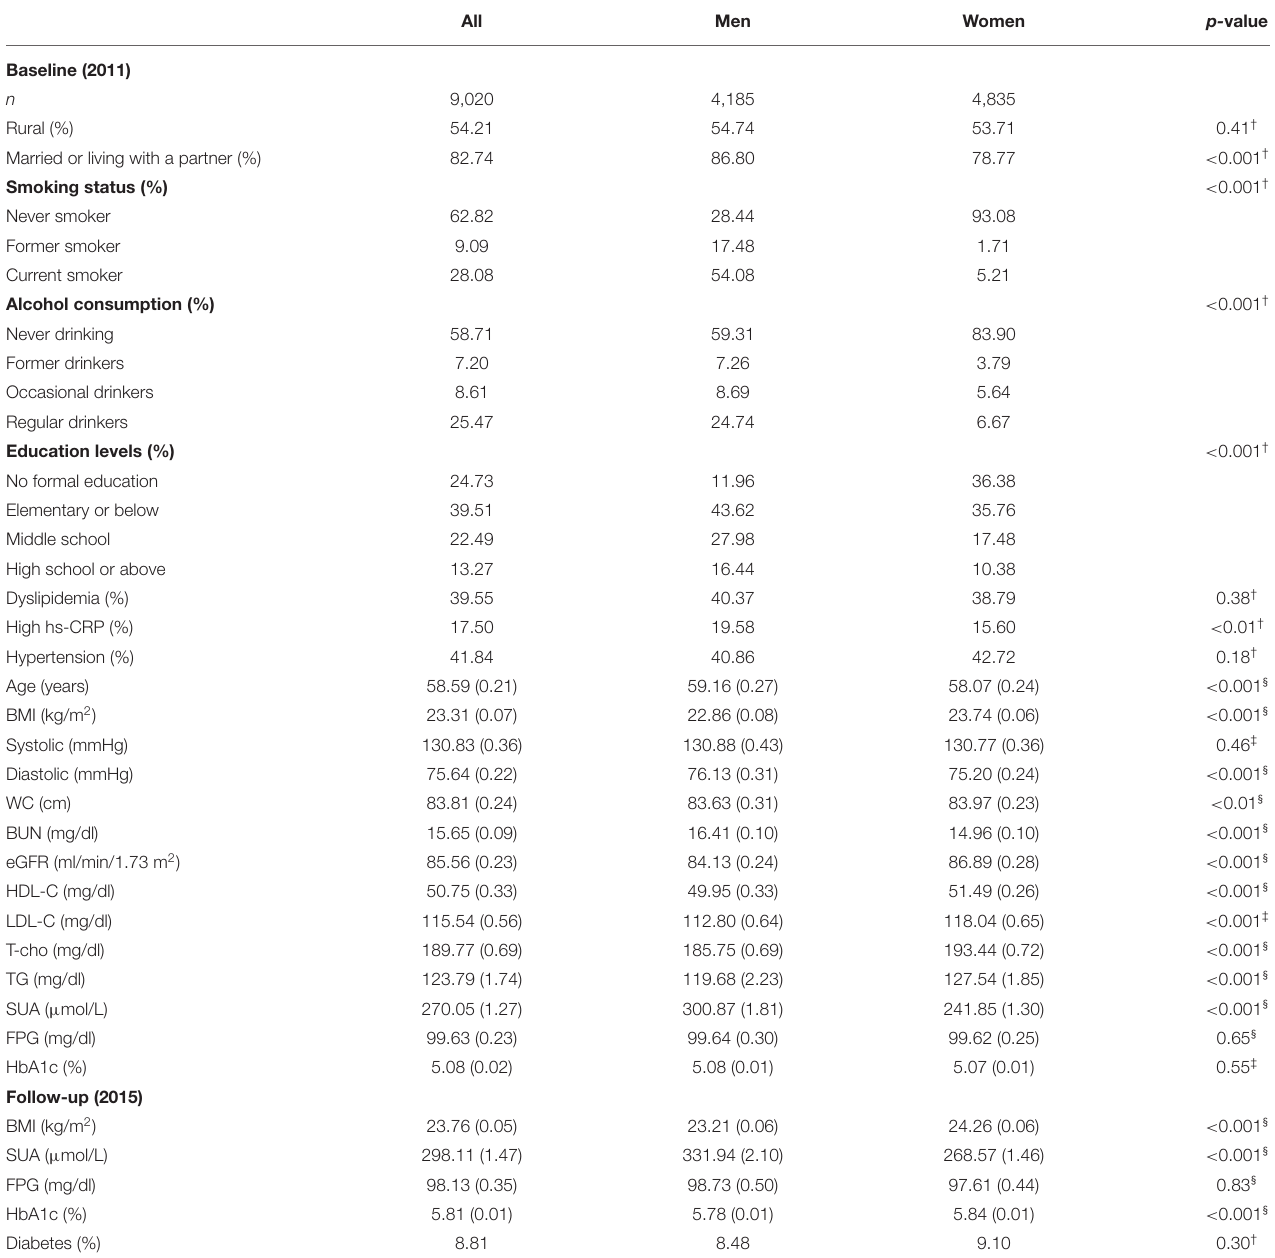
TABLE 1 | Weighted characteristics of the study participants according to different gender. All Men Women p-